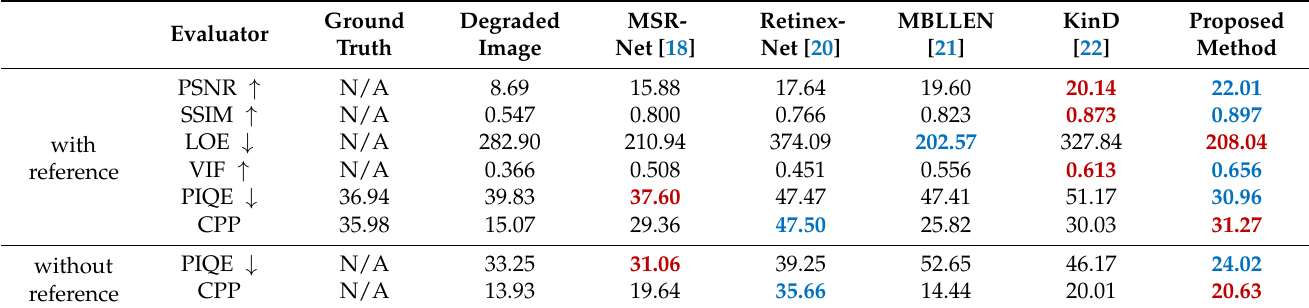
Table 1. Performance comparisons ( Blue : the best, Red : the second